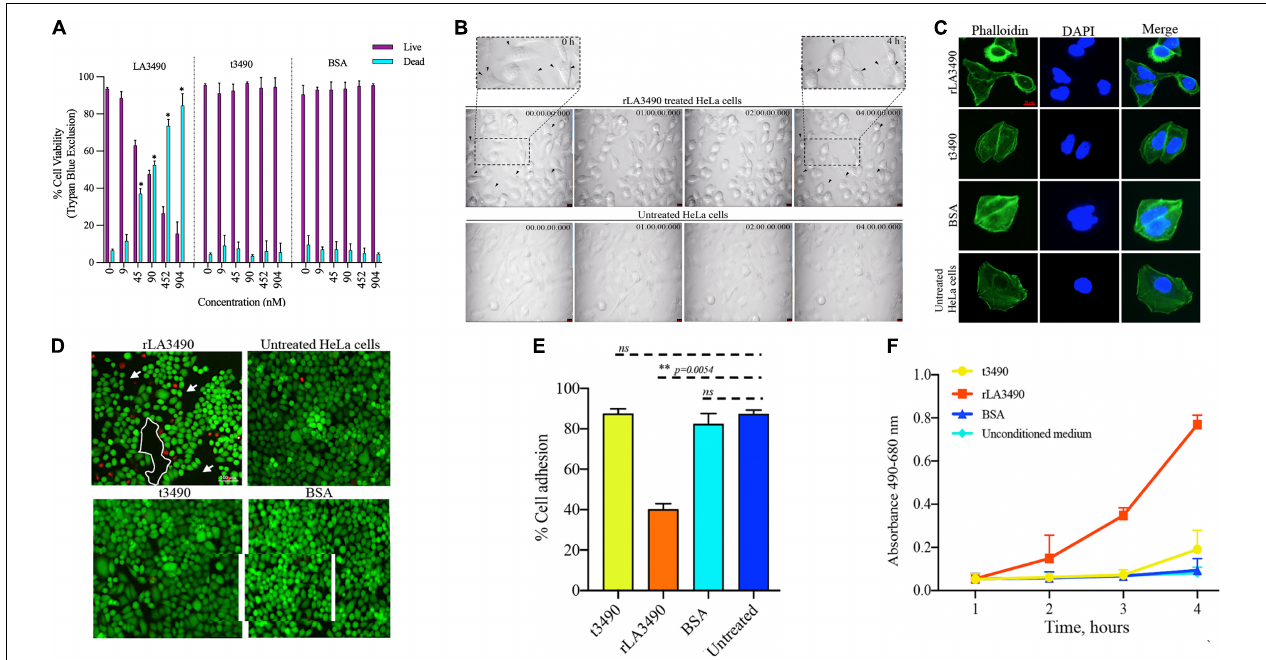
FIGURE 4 | Cytopathic effect of rLA3490. (A) Dose-dependent HeLa cell death induced by r3490 as assessed by trypan blue dye exclusion. Negative controls, t3490, BSA, and no treatment, had no such effect. Cell monolayers were treated with graded molar ratio doses (0 to 904 nM) of LA3490, t3490, and BSA for 4 h. Data represent mean ± SD of two independent experiments done with each condition in triplicate (paired t -test, ∗ p < 0.005 ). (B) Time-lapse phase-contrast microscopy images (40 frames, 5 s intervals) showing HeLa cell cytopathic effect following exposure to 45 nM of rLA3490 and controls. Only with rLA3490 was cell blebbing evident from 1 h onward [seen in zoom view (top left and right panel, black arrow)]. Time-lapse imaging was captured using a × 40 objective lens using a Leica DMi8 inverted microscope. Scale bar, 10 µ m. (C) Actin depolymerization occurs early after rLA3490 treatment. HeLa cell monolayers were incubated with 45 nM of rLA3490, t3490, and BSA up to 1 h. Monolayers were fixed with 4% paraformaldehyde followed by 0.1% Triton X-100 in PBS permeabilization. The monolayer was incubated with phalloidin-Alexafluor-488 nm conjugate, washed, and then mounted with ProLong TM Gold Antifade Mountant with DAPI. Images were captured using a Leica DMi8 confocal microscope [Alexa_488 nm (green), DAPI (blue)] at × 40 magnification. Untreated HeLa cells served as control. Scale bar, 20 µ m. (D) HeLa cell death induced by rLA3490 as assessed by fluorescent live/dead staining. Negative controls (t3490, BSA, and no treatment) had no such effect. Live/dead staining of HeLa cell monolayers was carried out after 4-h exposure to 45 nM rLA3490 (top left panel) and t3490 (bottom left). A dramatic decrease in adherent cells and concomitant accumulation of dead cells upon treatment with rLA3490, but not t3490 or BSA, was observed. Images were captured at × 10 magnification using a Leica DMi8 inverted microscope. Scale bar, 100 µ m. (E) Quantification of LA3490–induced detachment of HeLa cells from the monolayer following 4-h exposure, compared with negative control exposure (t3490, BSA, and no treatment). Cells were visibly dissociating from the monolayer after 1 h of rLA3490 exposure. (F) Quantification of time-dependent HeLa cell death by lactate dehydrogenase release after treatment with rLA3490 in comparison with negative controls. Groups were compared using the one-way t -test in GraphPad Prism 8 and considered statistically significant at p < 0.05 ; ns, non-significant. **means statistically significant with p =